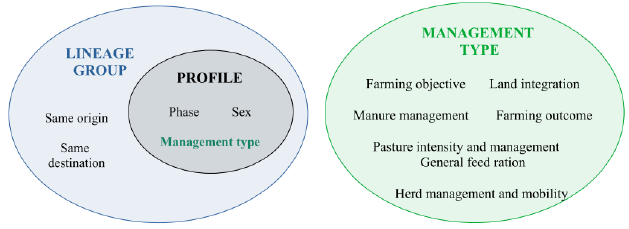
Figure 1. Description of MTs, LGs, and animal’s profiles .